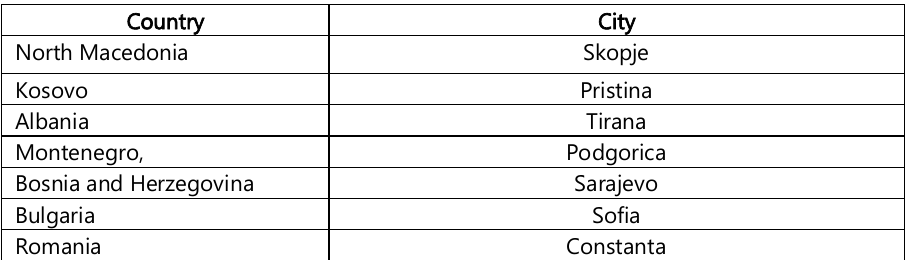
Table 2: Turkish Diyanet‟s Consultancy Offices and Attaches in the Balkans (Source: T.C. Cumhurba ş kanlı ğ